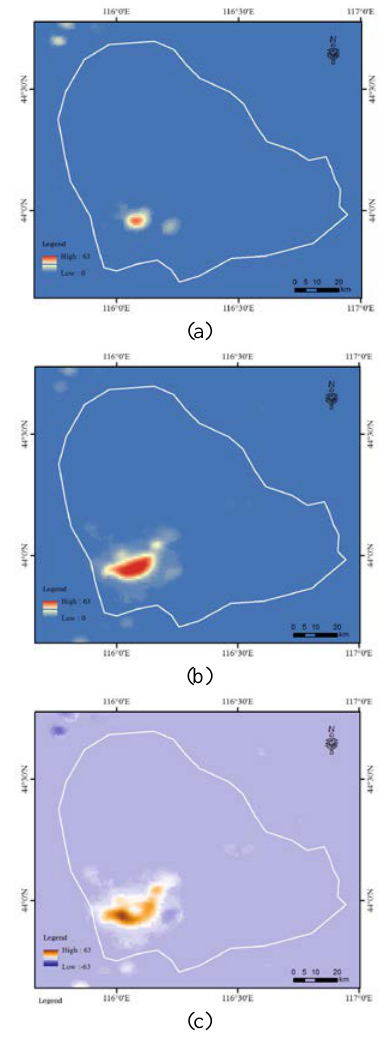
Figure 3. The trend of light pollution in XGNSPA (night-time light mean value in 1992-1995(a) and 2009-2012(b), the calculated change trend using MCD method)